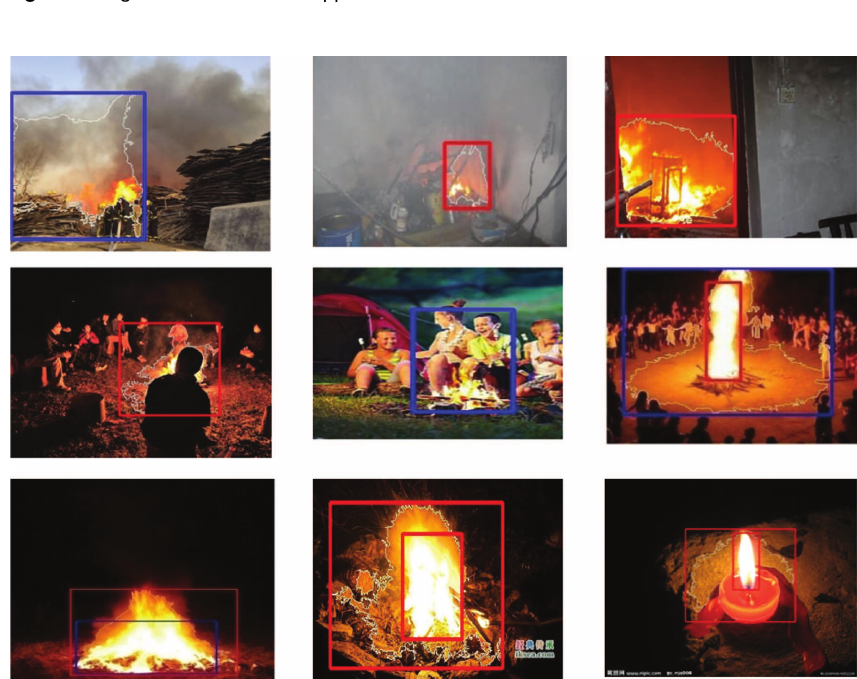
Figure 14: Candidate Regions that Contain Flame or Non-flame.